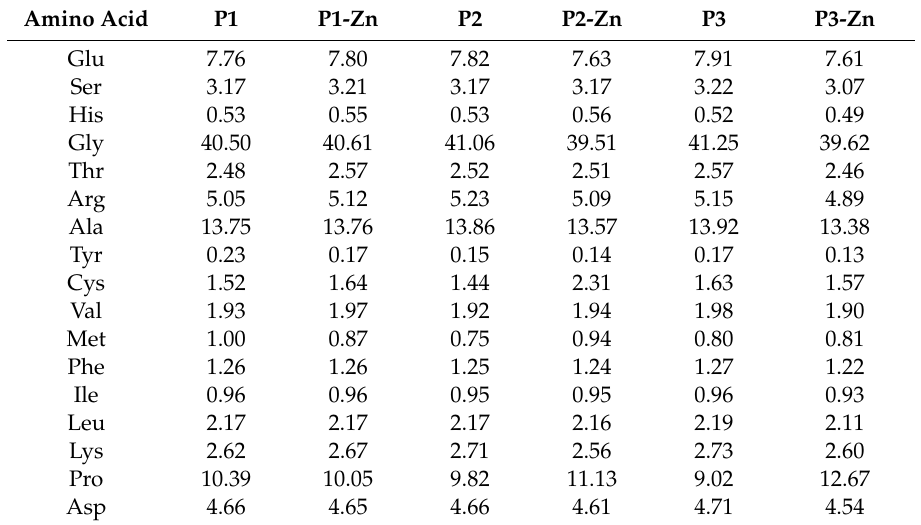
Table 2. Amino acid composition (mole / %) of three molecular weight peptide fractions and their zinc